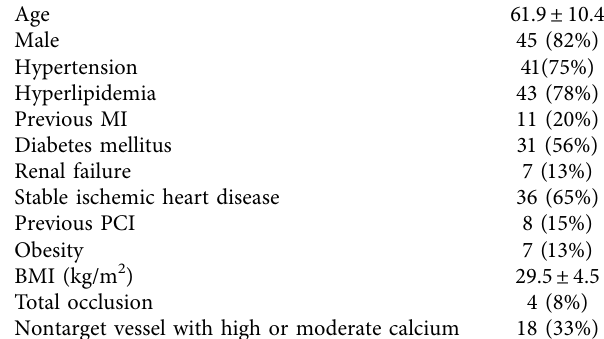
Table 1: Baseline characteristics of participants ( n � 55).